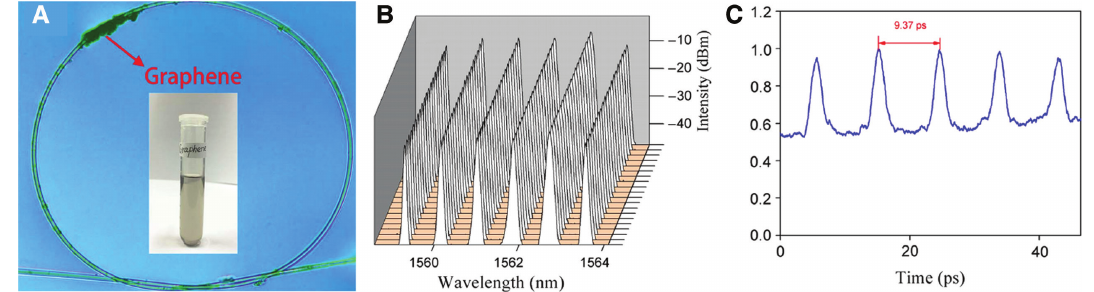
Figure 6: DFWM mode-locking operation in the Er-doped fiber laser. (A) Microscopy image of the graphene-deposited microfiber knot resonator. (B) Repeatedly recorded mode-locked spectrum at a 5-min interval. (C) Autocorrelation trace of filter-driven four-wave mixing mode-locking operation in the Er-doped fiber laser based on